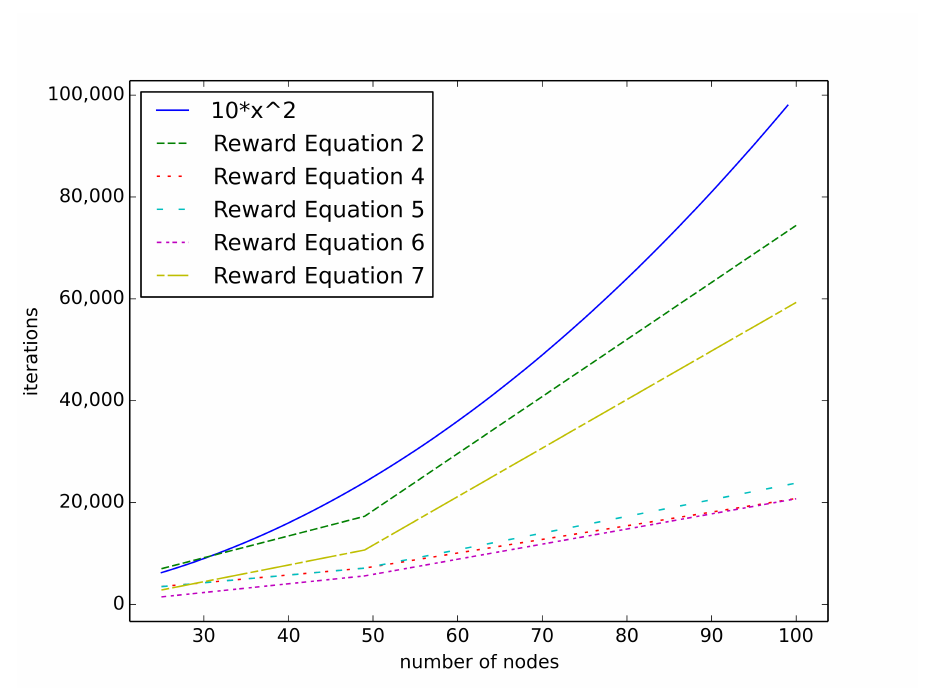
Figure 10. Scalability of SNCL without quick